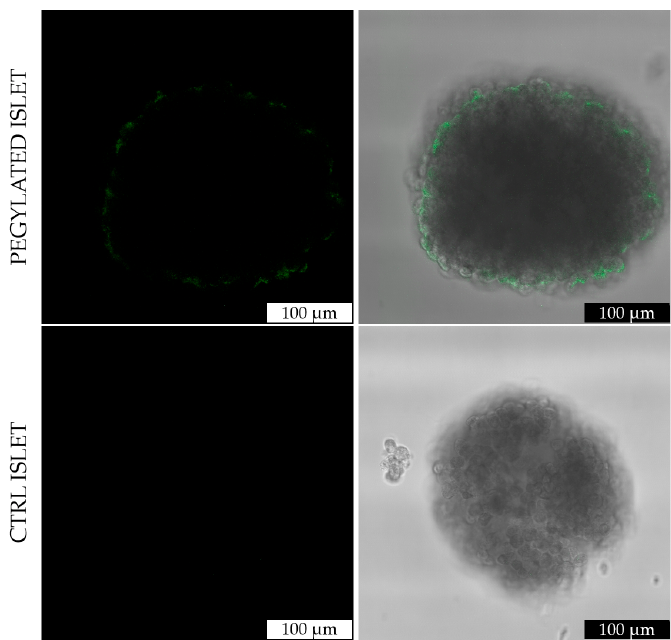
Figure 9. Confocal microscopy images showing (upper panels) an islet-hydrogel functionalized with Acryl-PEG-Anti-GFP and (lower panels) a CTRL islet stained with a secondary antibody (Alexa Fluor ® 488 goat Anti-Chicken). Scale bar = 100 μ m. 488 goat Anti-Chicken). Scale bar = 100 µ